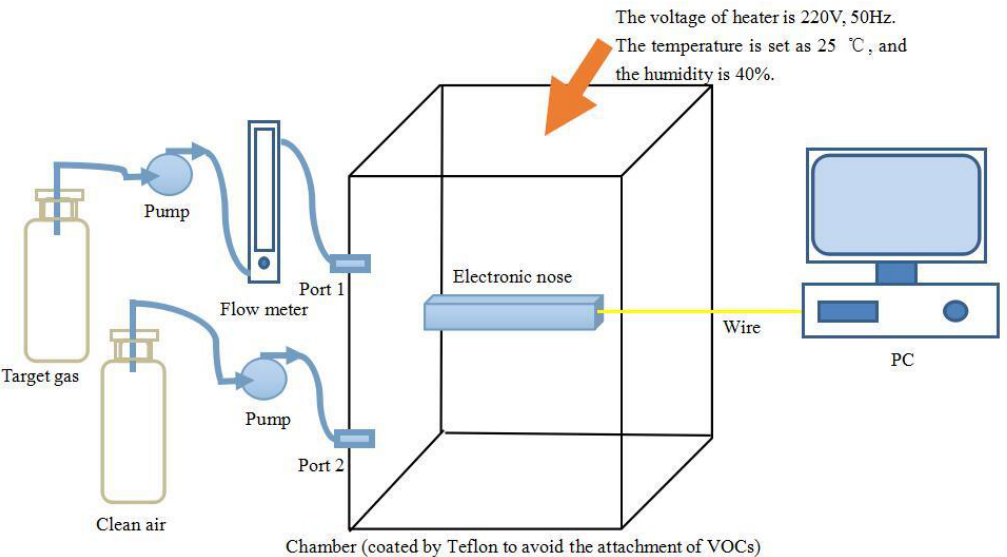
Figure 1. Schematic diagram of the experimental system.